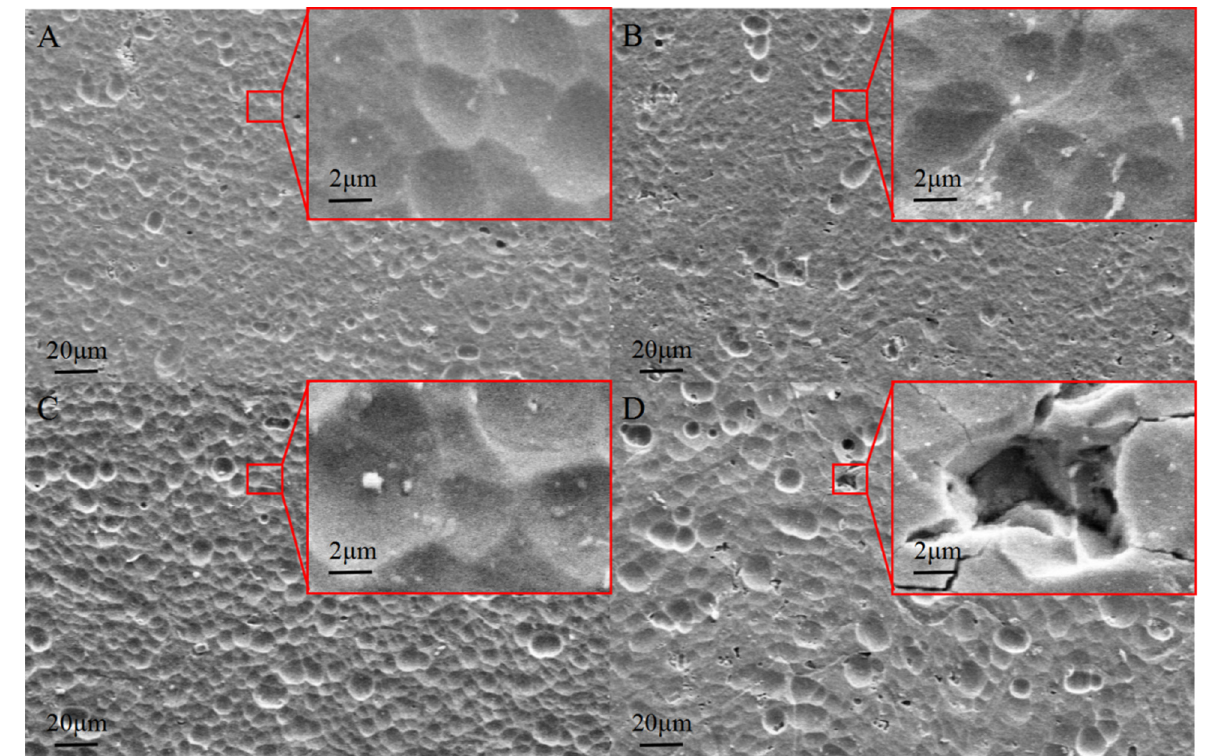
Figure 8. SEM characterization of surface morphology with different current density, ( A ) is 30 min, ( B ) is 60 min, ( C ) is 90 min and ( D ) is 120 min. Table 6. Ra and Rmax values with different oxidation time.